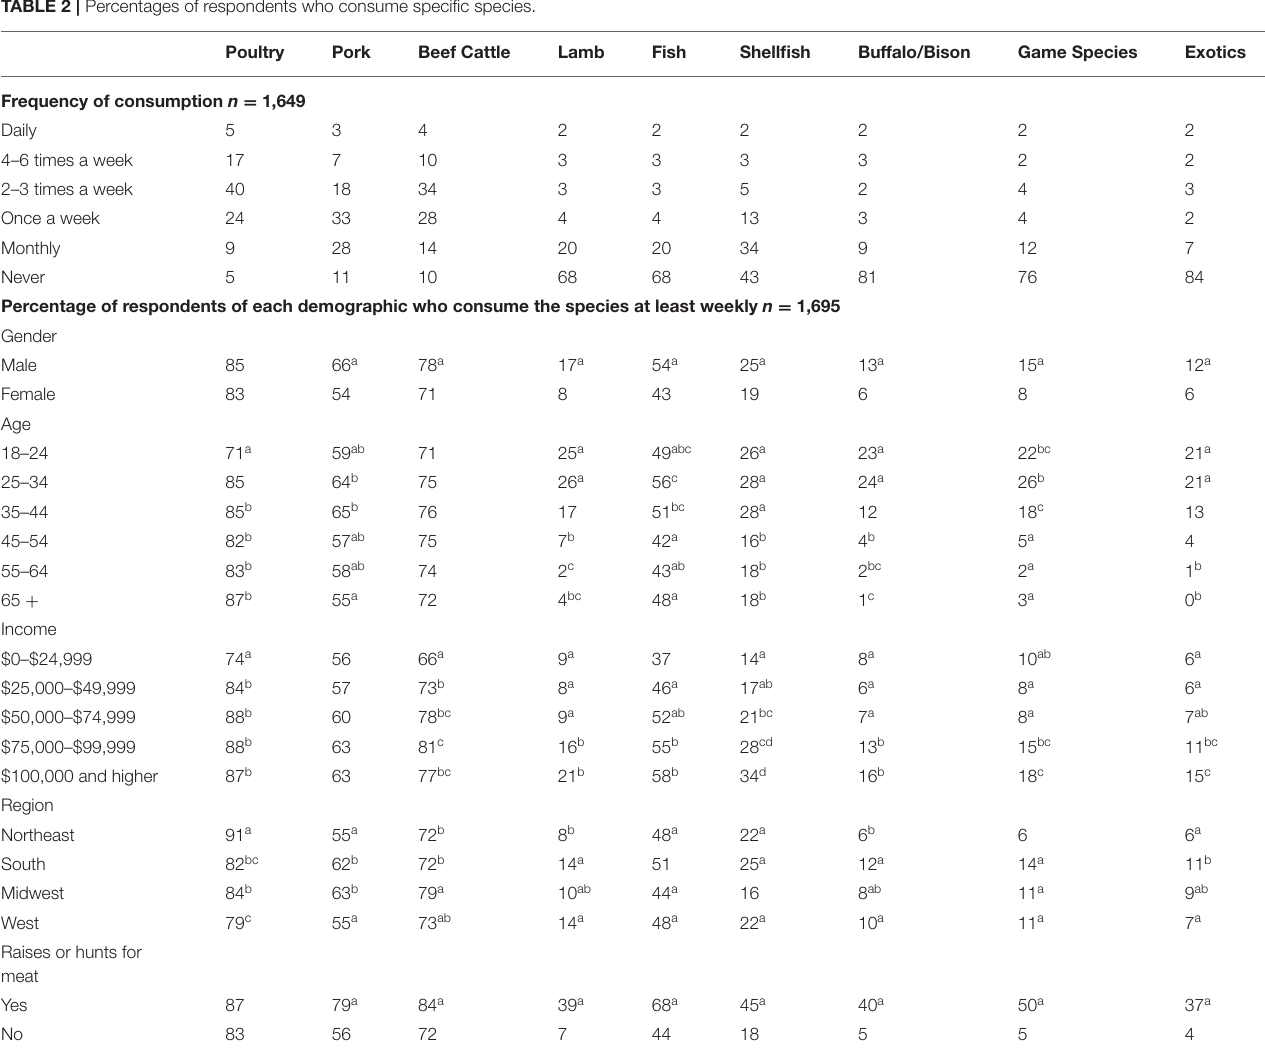
TABLE 2 | Percentages of respondents who consume specific